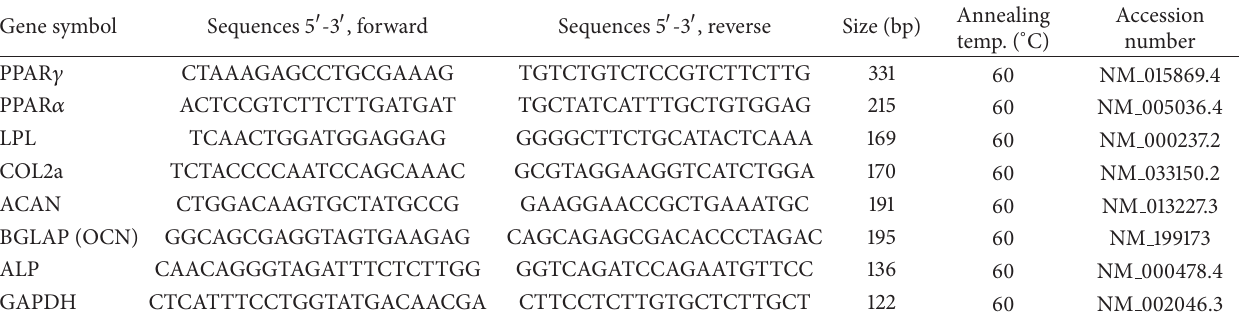
Table 2: List of primers used in this study